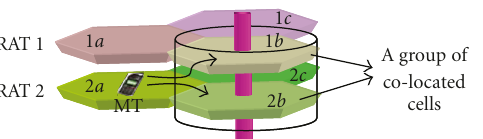
Figure 1: Two-RAT heterogeneous cellular networks with colocated